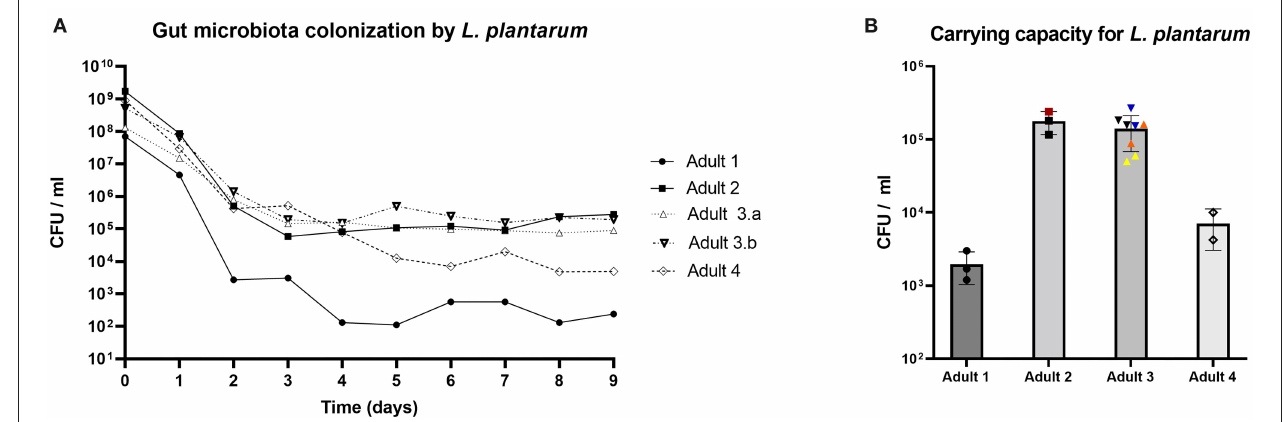
FIGURE 2 | Colonization levels of L. plantarum in representative TRs connected during the first treatment period to the IR seeded with immobilized human adult fecal microbiota. (A) L. plantarum was added at day 0 to the microbiota to reach 10 8 to 10 9 CFU/ml in TRs. The y-axis represents L. plantarum viable cell counts per ml reactor effluent. (B) Average carrying capacity for L. plantarum in different cultivated microbiota, whereas each data point represents one TR. Black: L. plantarum NZ3400B; red: L. plantarum IA10; blue: L. plantarum 1 LP_RS14990; orange: L. plantarum PA1.2_01 and NZ3400B; yellow: L. plantarum PA2_06 and NZ3400B. •: